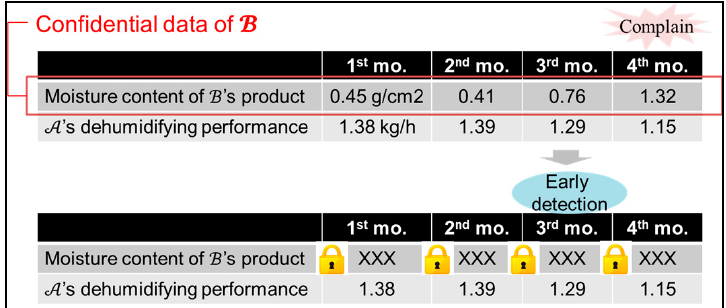
Figure 5. An actual business example of concrete data collaboration.